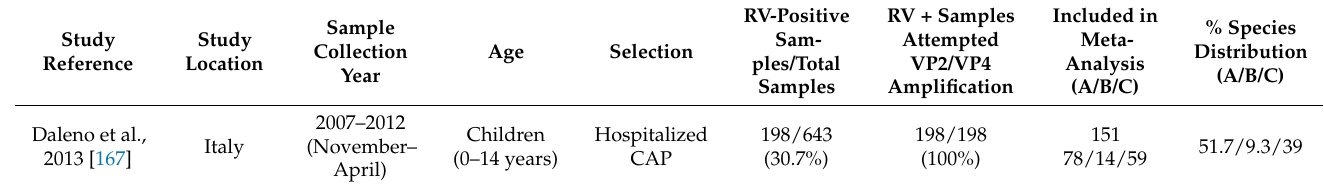
Table A1. Details of clinical studies used in the final meta-analysis. Abbreviations: ILI: